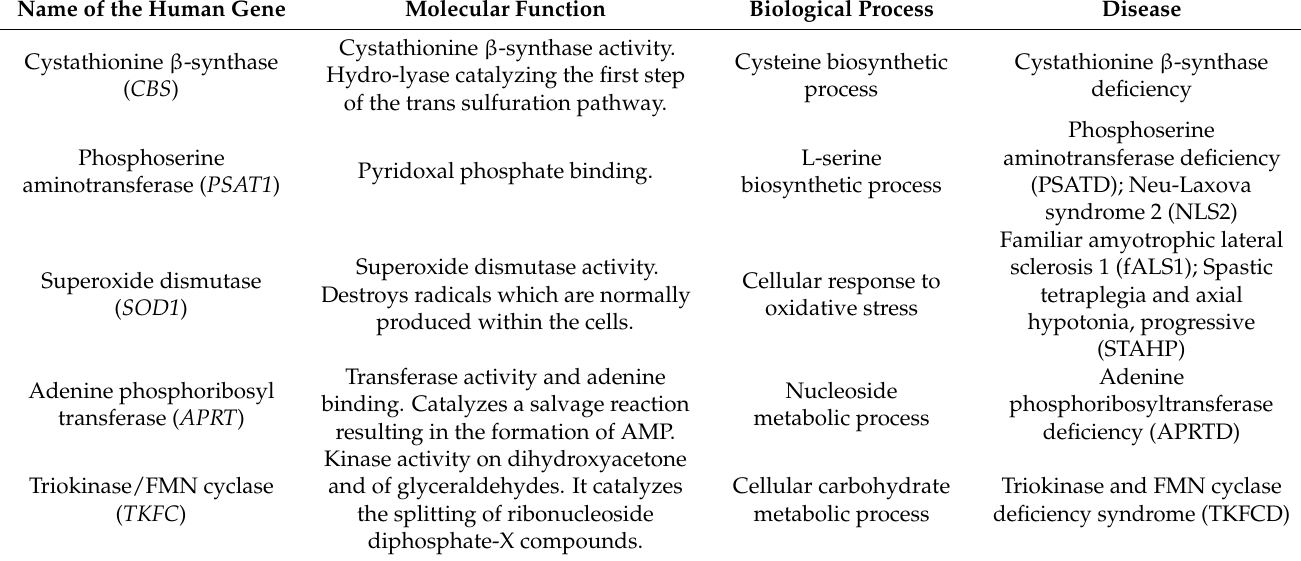
Table 1. List of genes involved in Mendelian diseases that were studied in the yeast Saccharomyces cerevisiae . Name of the Human Gene